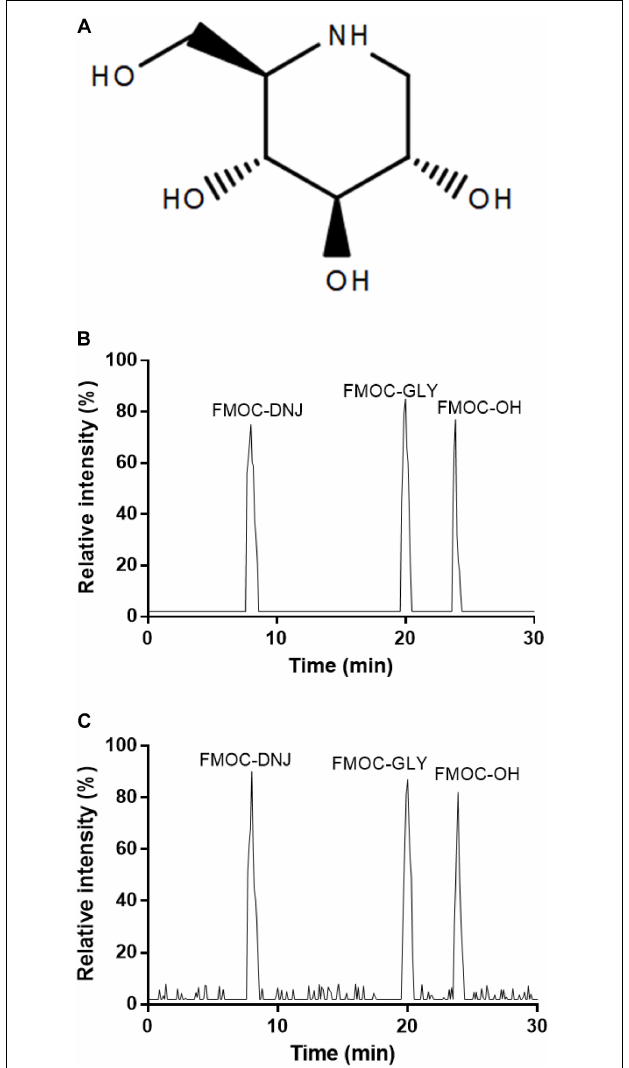
FIGURE 1 | HPLC analysis of DNJ (1-deoxynojirimycin). (A) The structure of DNJ derivatives. (B) DNJ standard. (C) Purified DNJ derivatives from mulberry